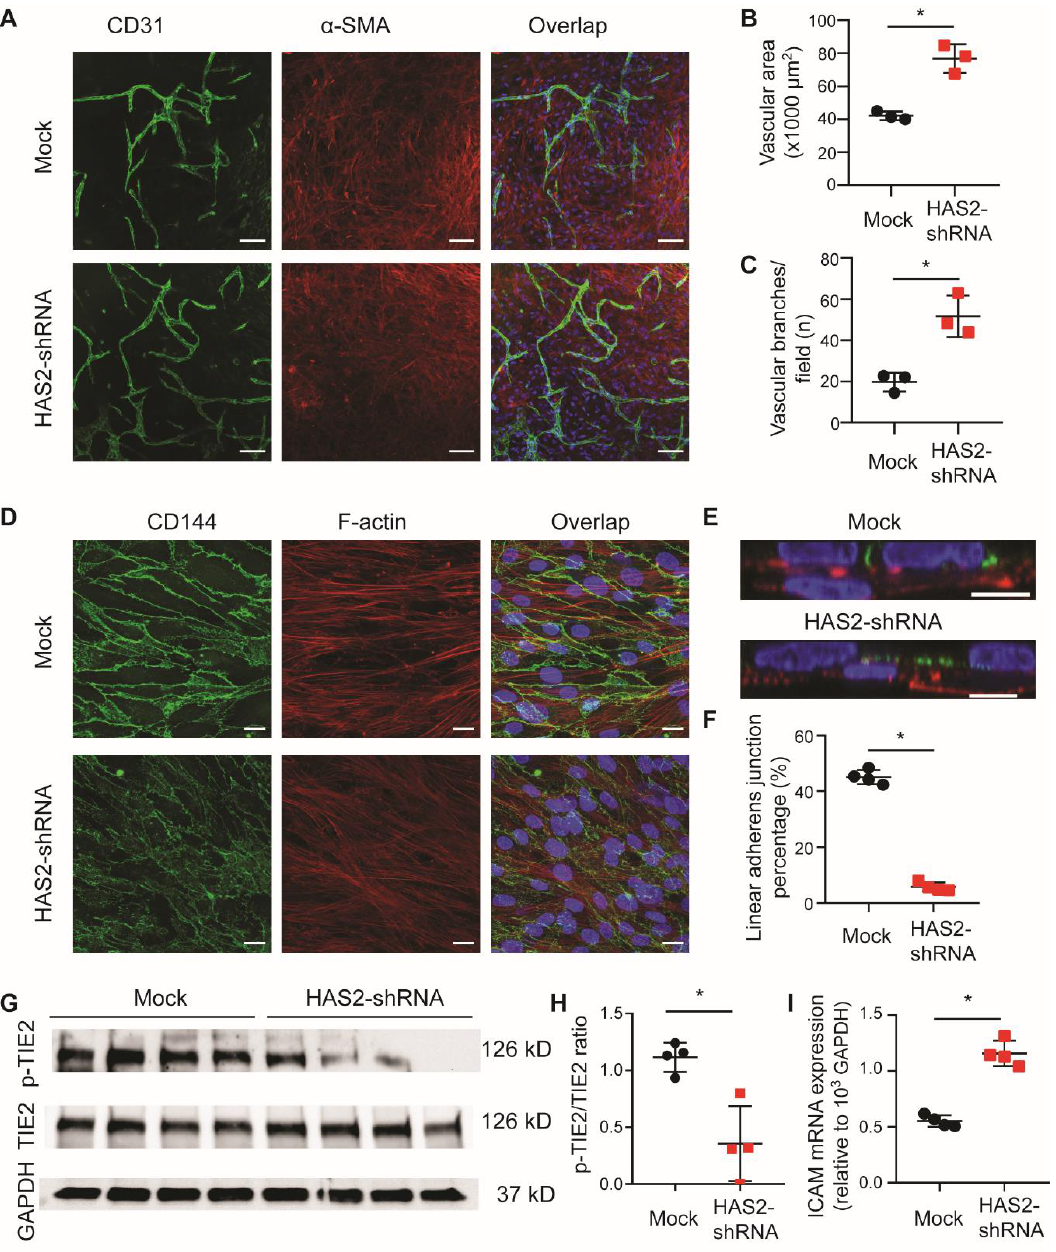
Figure 4. Loss of hyaluronan in ECs increases angiogenesis and endothelial destabilization. To test the function of HA in vitro, a short hairpin RNA ( HAS2 -shRNA) was used to silence HAS2 expression in ECs. ( A ) Representative images of EC-pericyte coculture angiogenesis plexus assay stained with CD31 (green) and α-SMA (red) (scale bar = 100 µm). Quantification of both ( B ) vascular area and ( C ) vascular branches show increased angiogenesis with silencing of HAS2 ( n = 3). ( D ) Representative images of EC-pericyte coculture ( n = 4, scale bar = 20 µm) and ( E ) its side view stained for VE-Cadherin/CD144 (green) and F-actin (red), which ECs (VE-cadherin positive) stay on top of pericytes (scale bar = 10 µm). ( F ) Quantification of linear adherens junctions shows endothelial destabilization with silencing of HAS2 ( n = 4). ( G ) Images and ( H ) quantification of western blot for p-Tie2, Tie2 and GAPDH show a reduced Tie2 activation with silencing of Has2 ( n = 4) compared to control ( n = 4). ( I ) An increased ICAM mRNA expression is shown with silencing of Has2 ( n = 4), indicates ECs activation after loss of HA. Values are given as mean ± SD. * p < 0.05.